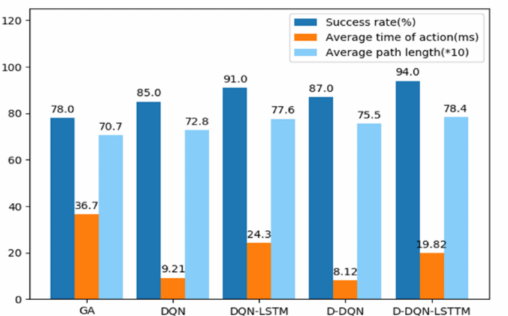
Figure 7. Comparison of the performances (success rate, single-action execution time, average path length) of different algorithms in 200 random environments.